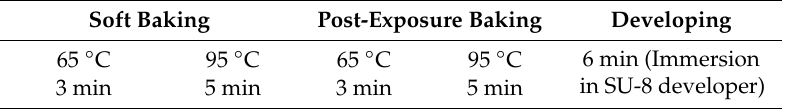
Table 1. Processing parameters of the 75 µm SU-8 2050 for experimental validation.